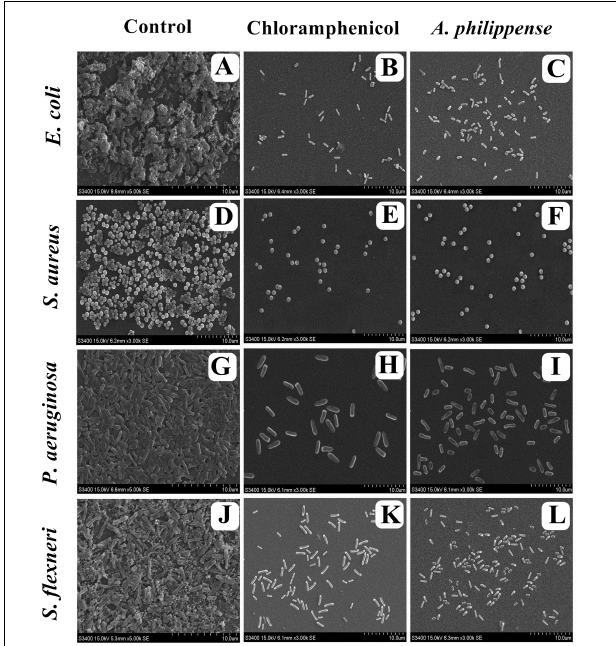
FIGURE 7 | Micrographs of disrupted matured biofilms of tested strains formed on glass surfaces by the A. philippense crude extract at their respective MICs by scanning electron microscopy. (A,D,G,J) Growth control; (B,E,H,K) Positive control chloramphenicol; and (C,F,I,L) A. philippense crude extract.